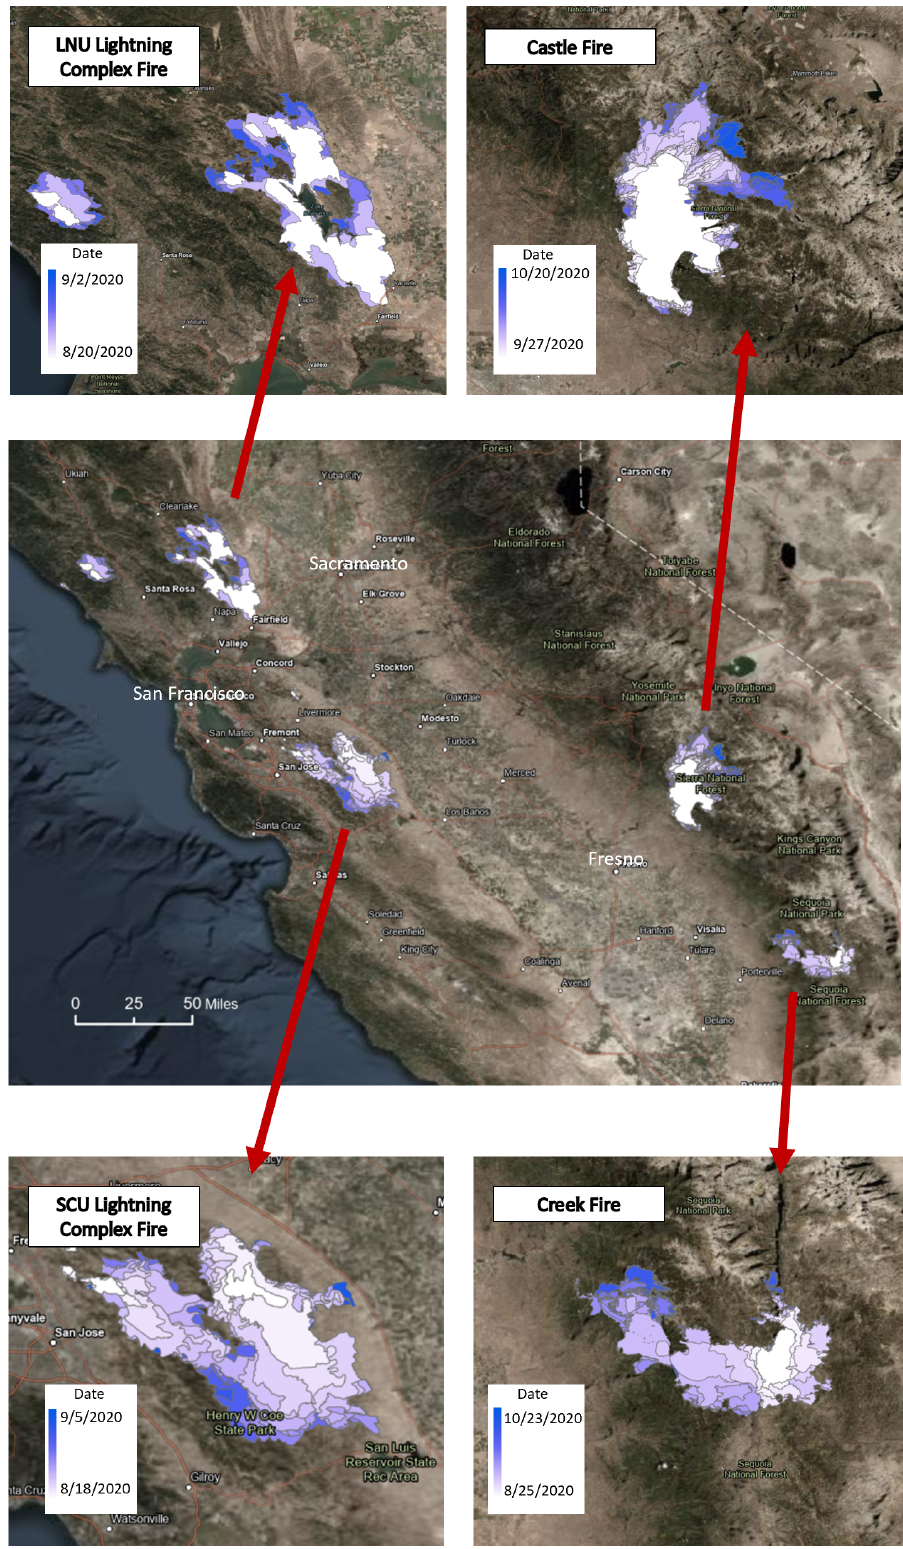
Figure 4. Evolution of fire perimeter in during the study period.